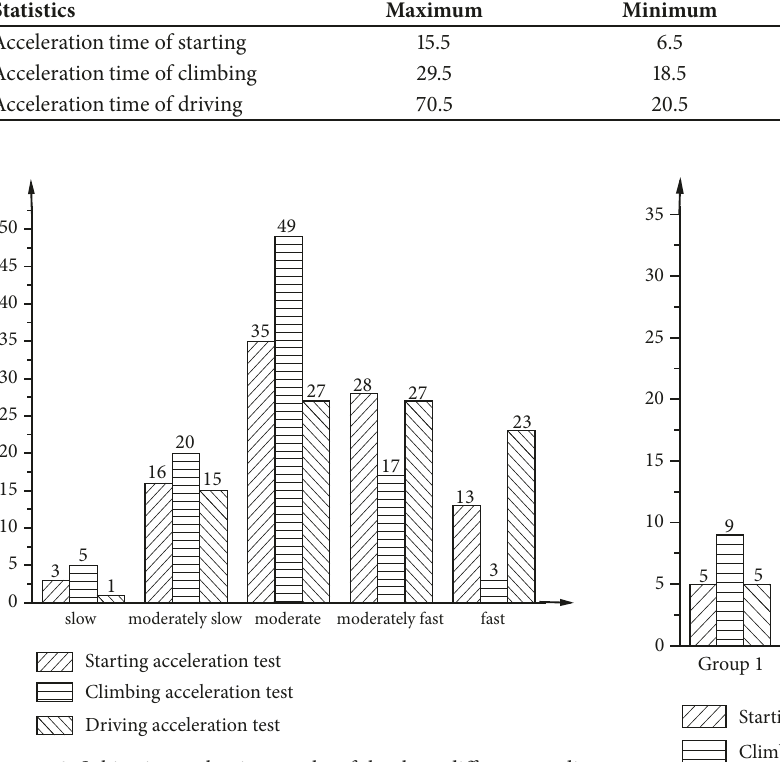
Figure 3: Subjective evaluation results of the three different condi- tions.